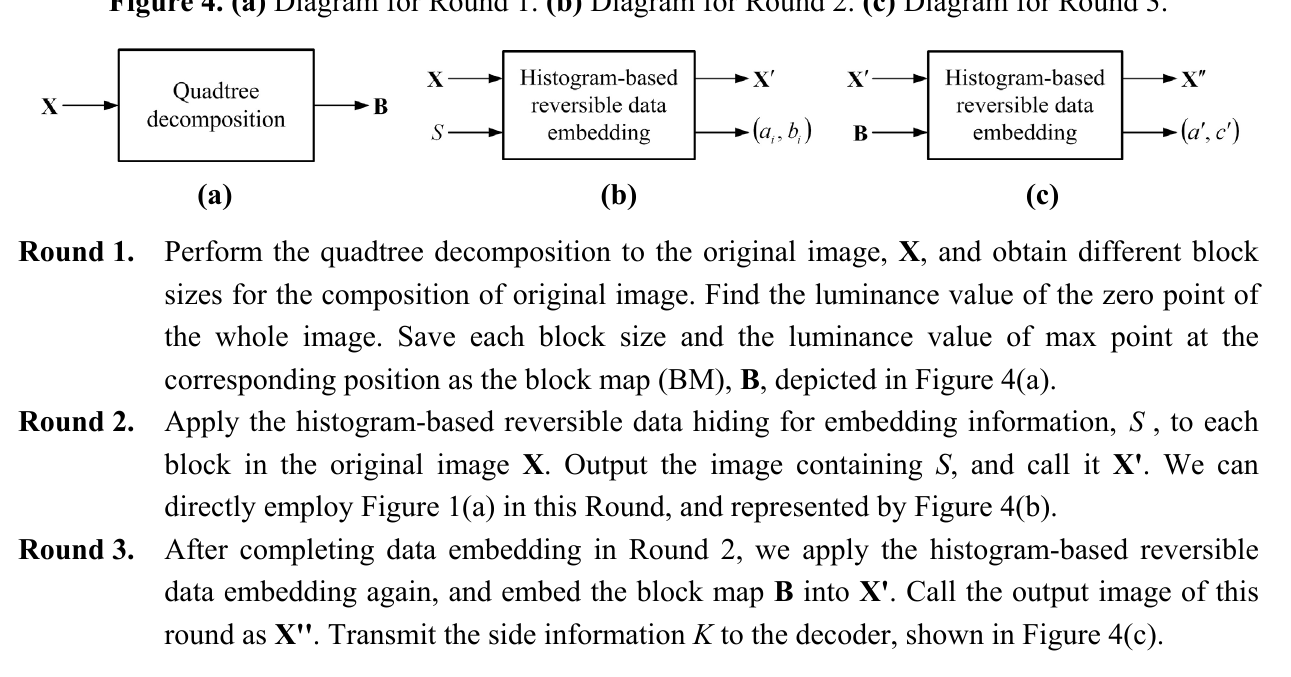
Figure 4. (a) Diagram for Round 1. (b) Diagram for Round 2. (c) Diagram for Round 3.